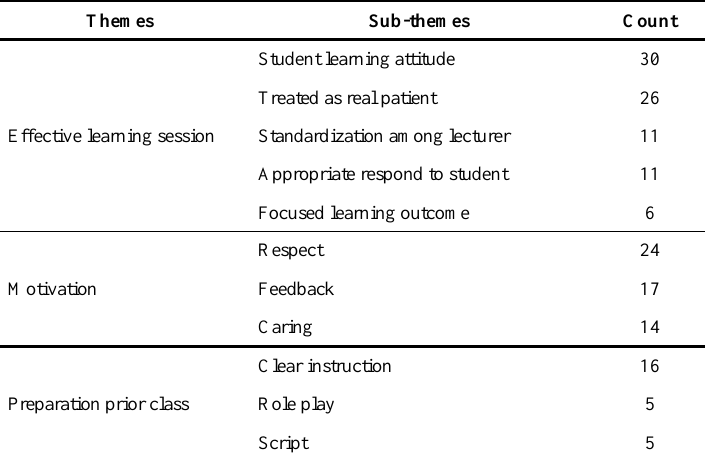
Table 1. Themes and sub-themes for